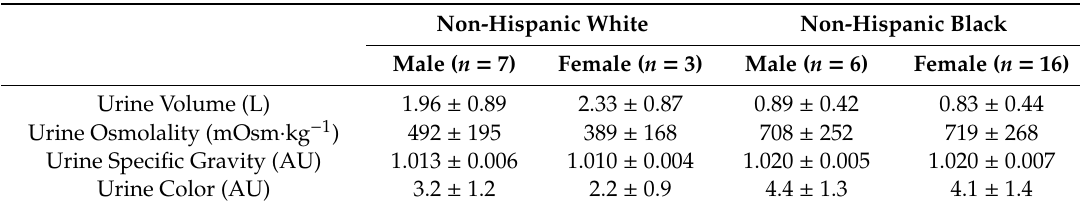
Table 3. The 24 h urinary hydration measures between non-Hispanic White and non-Hispanic Black males and